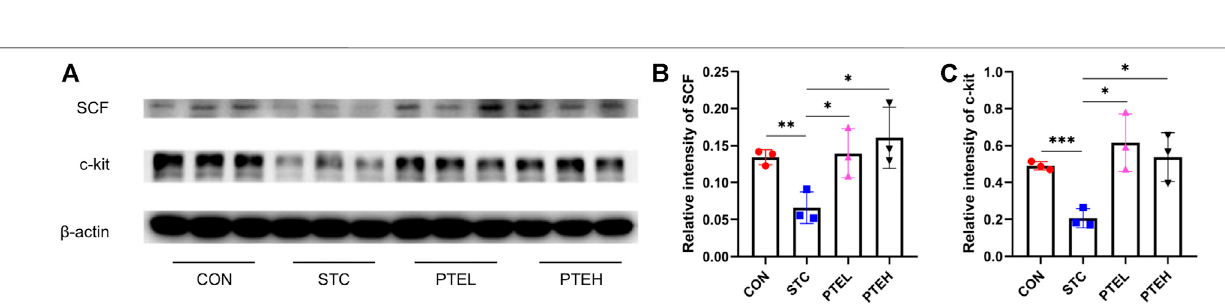
FIGURE3| Proteinexpressionofcleavedcaspase-3incolontissues (A) . (B) Thequantitativeanalysiswascalculatedandshownin (B) . n =3.* p < 0.05,*** p < 0.01.